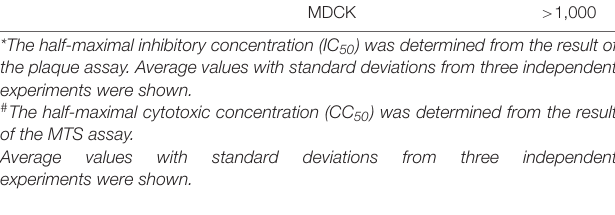
TABLE 2 | IC 50 of SMeFM for the propagation of influenza virus clinical isolates. Strain IC 50 (nM)* A/KANAGAWA/ZC1802/2018